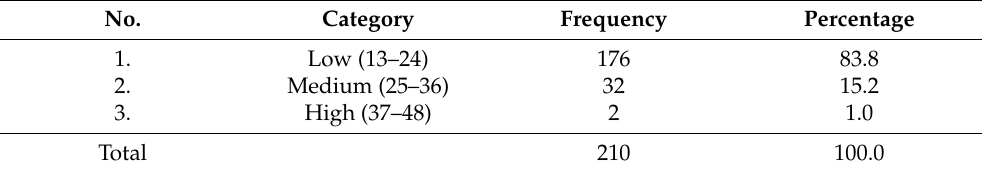
Table 5. Distribution of MSME actors in agriculture based on the business actors’ ability in the city of Surakarta. No. Category Frequency Percentage 1. Low (13–24) 176 83.8 2. Medium (25–36) 32 15.2 3. High (37–48) 2 1.0 Total